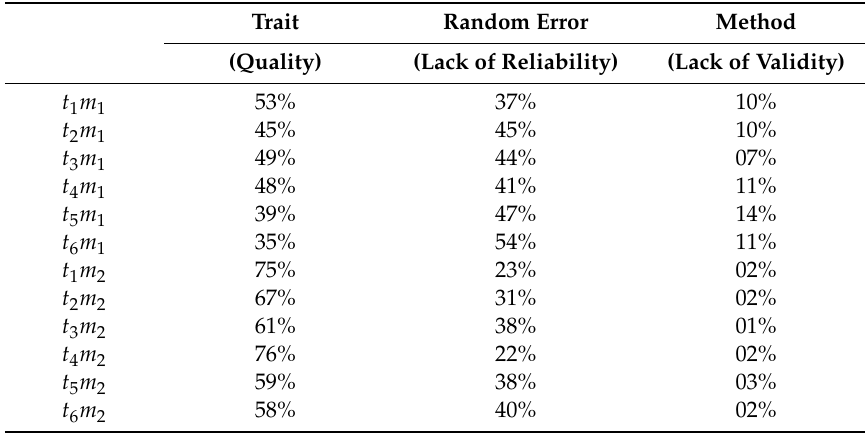
Table 3. Measurement quality. Percentages of explained